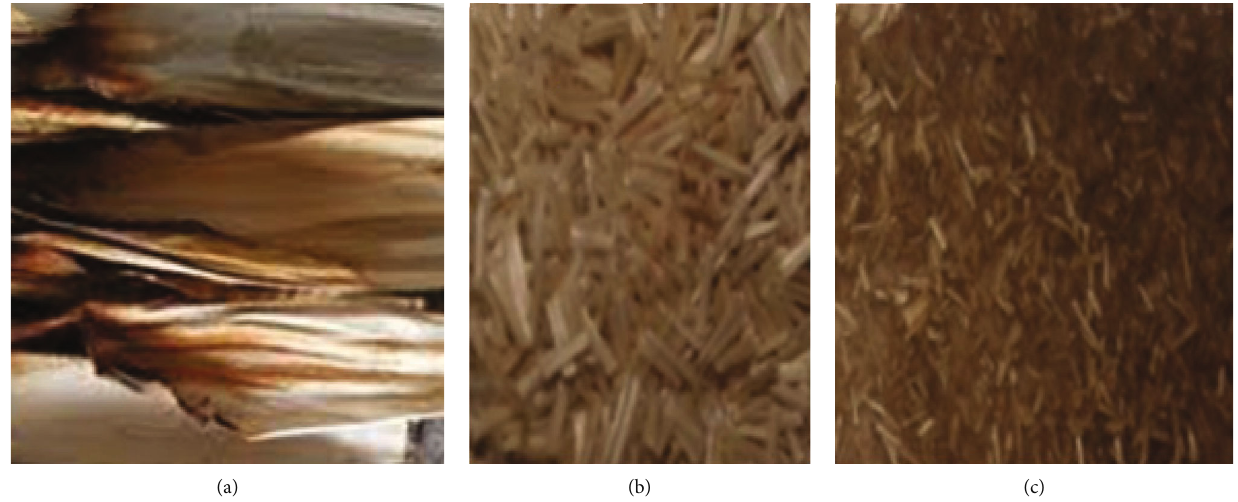
Figure 1: (a) Areca nut leaf, (b) sliced areca nut leaf sheath, and (c) chopped and sieved areca nut leaf sheath. Table 1: Areca nut leaf sheath fi ber chemical composition [55,